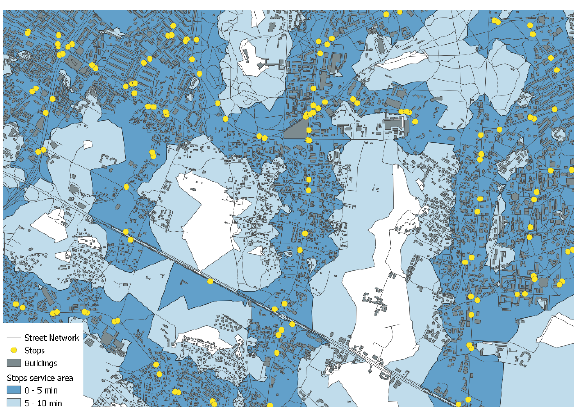
Figure 5. Service area of public transport stops in Southern